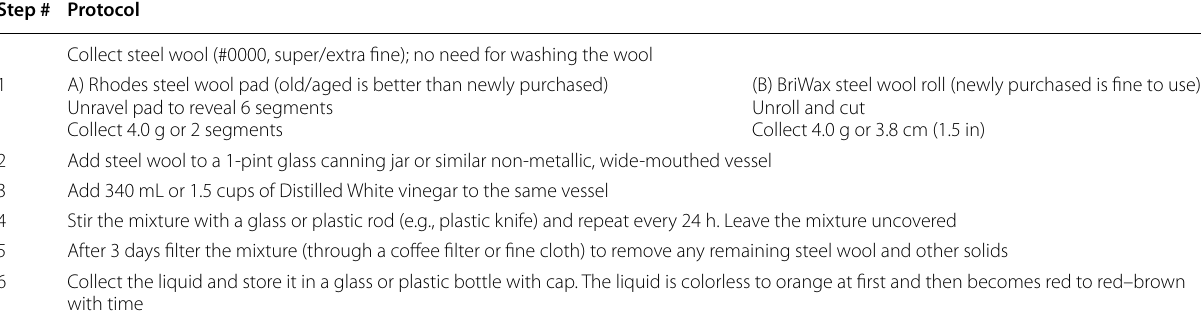
Table 3 Protocol for preparing an iron acetate solution for ebonizing wood Step #